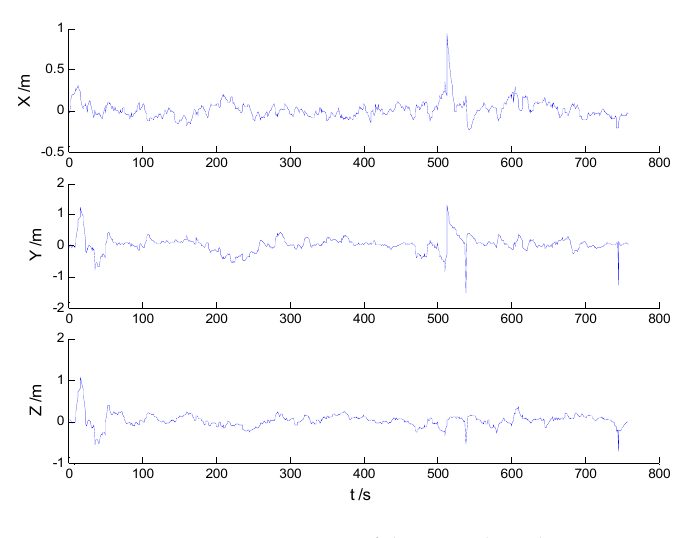
Figure 7. Position errors of the AKF algorithm.